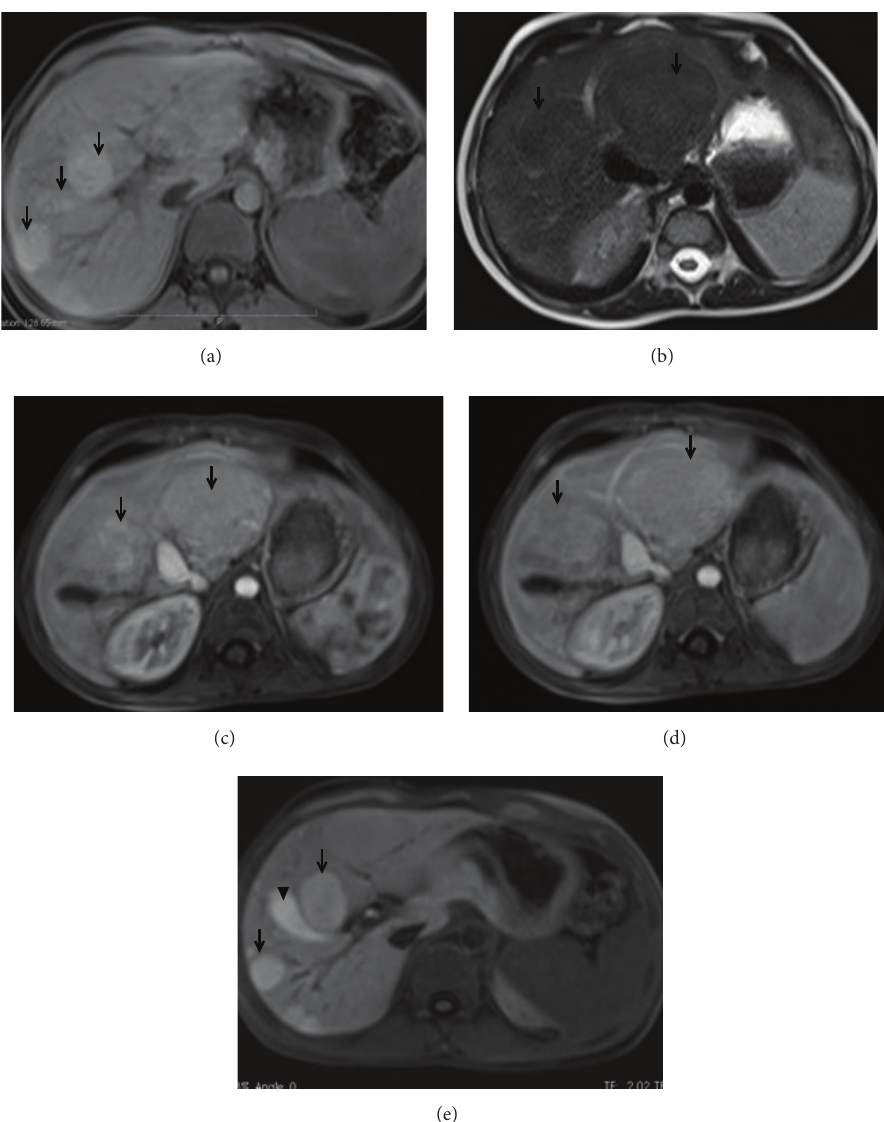
Figure 11: A 4-year-old boy with vague upper abdominal pain and abdominal distension since he was 2 years old. Axial T1-W image (a) shows multiple well-defined hyperintense lesions (arrows). The lesions are hypointense on T2-W images (b, arrows). Slight arterial hyperenhancement is seen with the lesions (c, arrows). There is retention of contrast in the portal venous phase (d, arrows). Hepatobiliary phase image (e) shows retention of contrast (arrows). Arrow head points to biliary excretion of contrast into gallbladder. Imaging features favouring nodular regenerative hyperplasia include multiple lesions, T1-W hyperintensity, arterial hyperenhancement, and retention of contrast on portal venous and equilibrium